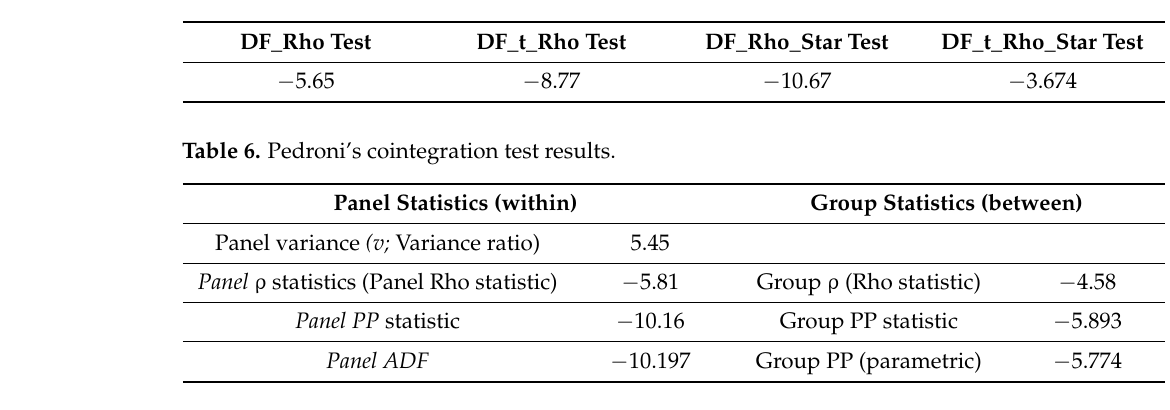
Table 5. Kao’s test results.